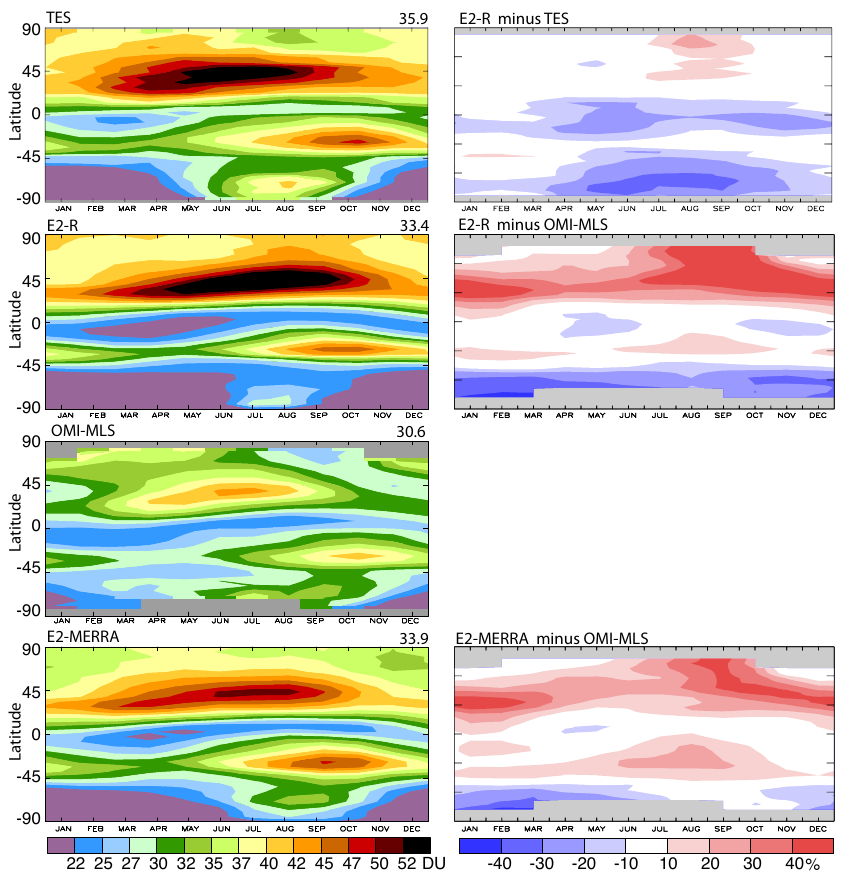
Fig. 6. Seasonality of zonal mean tropospheric ozone column (DU; left column) in the given models and observations and model-observation differences (%; right column). Global mean column values are given in the upper right of each panel. All analyses use the NCEP